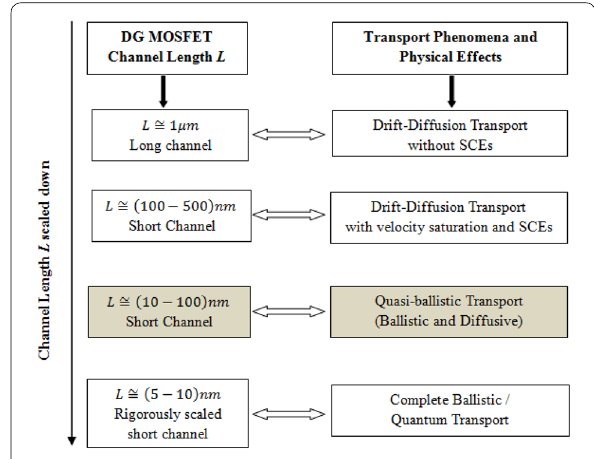
Fig. 1 Different transport phenomena and physical effects arising when the channel length L of a DG MOSFET undergoes rigorous scaling. The grey shaded area is the core device channel length regime for the proposed